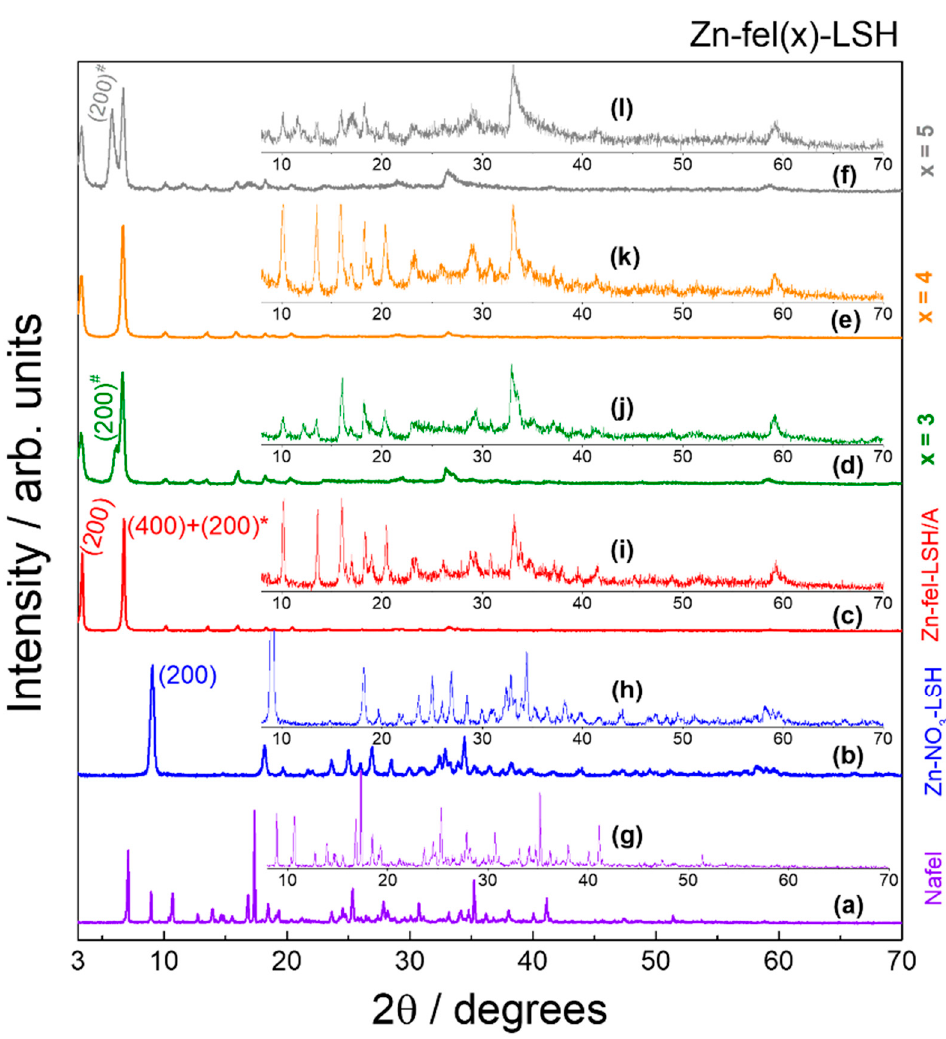
Figure 1. XRD patterns of ( a ) sodium ferulate salt (Nafel—NaC 10 H 9 O 4 ), ( b ) Zn-NO 3 -LSH host matrix, ( c ) Zn-fel-LSH/A, ( d ) Zn-fel(3)-LSH, ( e ) Zn-fel(4)-LSH, and ( f ) Zn-fel(5)-LSH in the 3 − 70 ◦ /2 θ region. Figures inserted show magnified X-ray diffraction lines of ( g ) Nafel salt (NaC 10 H 9 O 4 ), ( h ) Zn-NO 3 -LSH host matrix, ( i ) Zn-fel-LSH/A, ( j ) Zn-fel(3)-LSH, ( k ) Zn-fel(4)-LSH, and ( l ) Zn-fel(5)-LSH in the 8 − 70 ◦ /2 θ